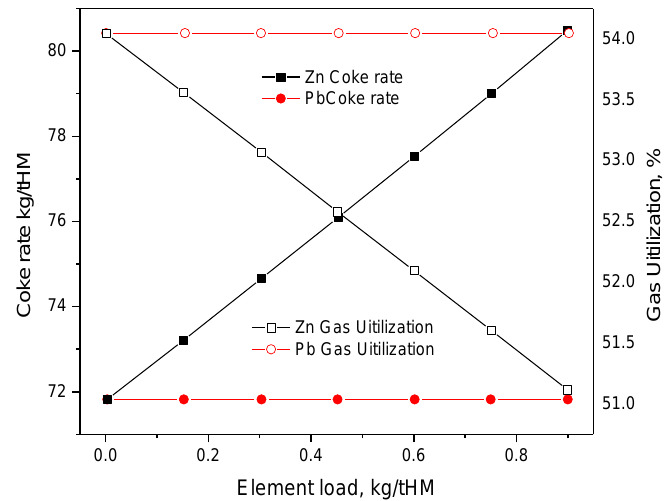
Figure 3. Variation of the coke rate under various Zn and Pb loads.